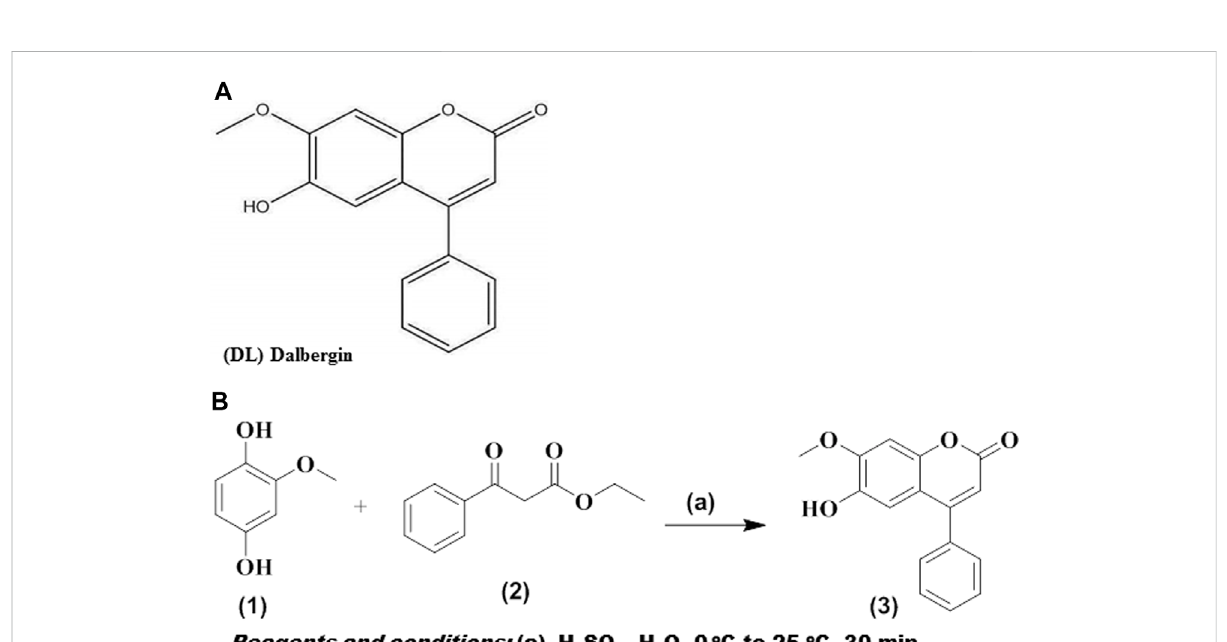
FIGURE 1 (A) Structure of dalbergin (B)